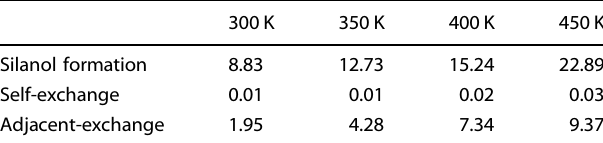
Table 1. Accumulated number of reactions per unit volume (#/nm 3 ) during 3 ns simulation for the three ion-exchange processes at different